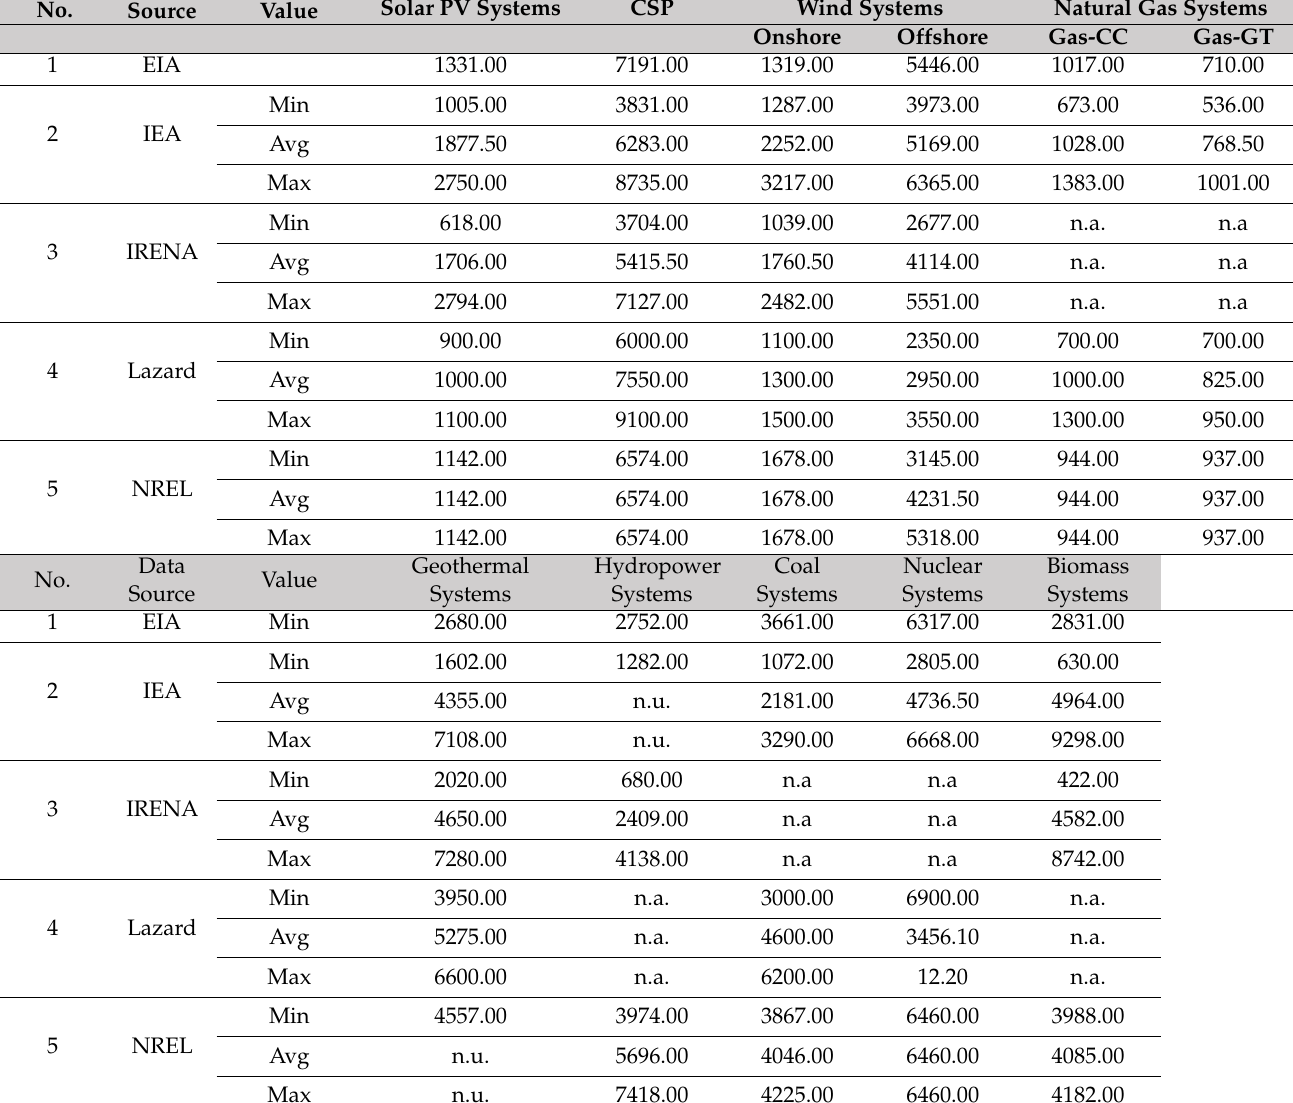
Table 2. The cost of different RES (USD/kW, 2019